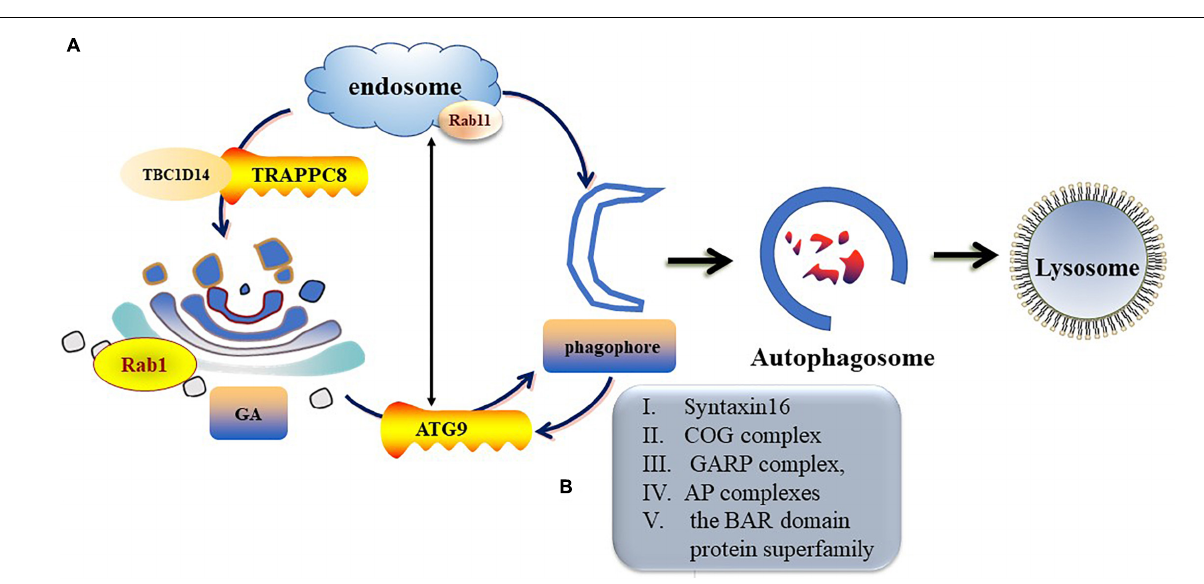
FIGURE 3 | Trafficking of mATG9 in different conditions. (A) Under nutrient-rich conditions, ATG9 is mainly colocalizes with TGN and endosomes. During starvation-induced autophagy, mAtg9 redistributes from TGN to juxtanuclear region. ATG9 relocate to the Golgi from RAB11-positive recycling endosomes to RAB1-positive Golgi compartments is controlled by a complex including TBC1D14 and mammalian TRAPPIII. (B) Syntaxin16, oligomeric Golgi (COG) complex, Golgi-associated retrograde protein (GARP) complex, adaptor protein (AP) complexes and the BAR domain protein superfamily take part in the regulation of ATG9